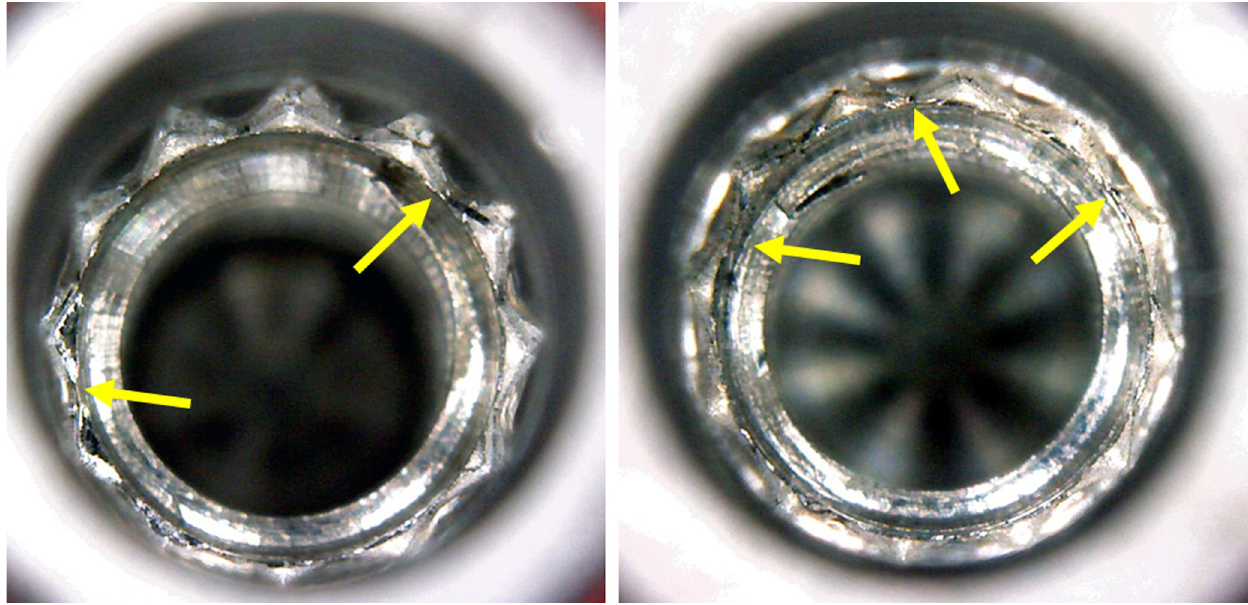
Fig 8. Representative image showing the rounding of angles (yellow arrows) in the samples of both MT groups after the application of 100 and 120 Ncm of torque, respectively.